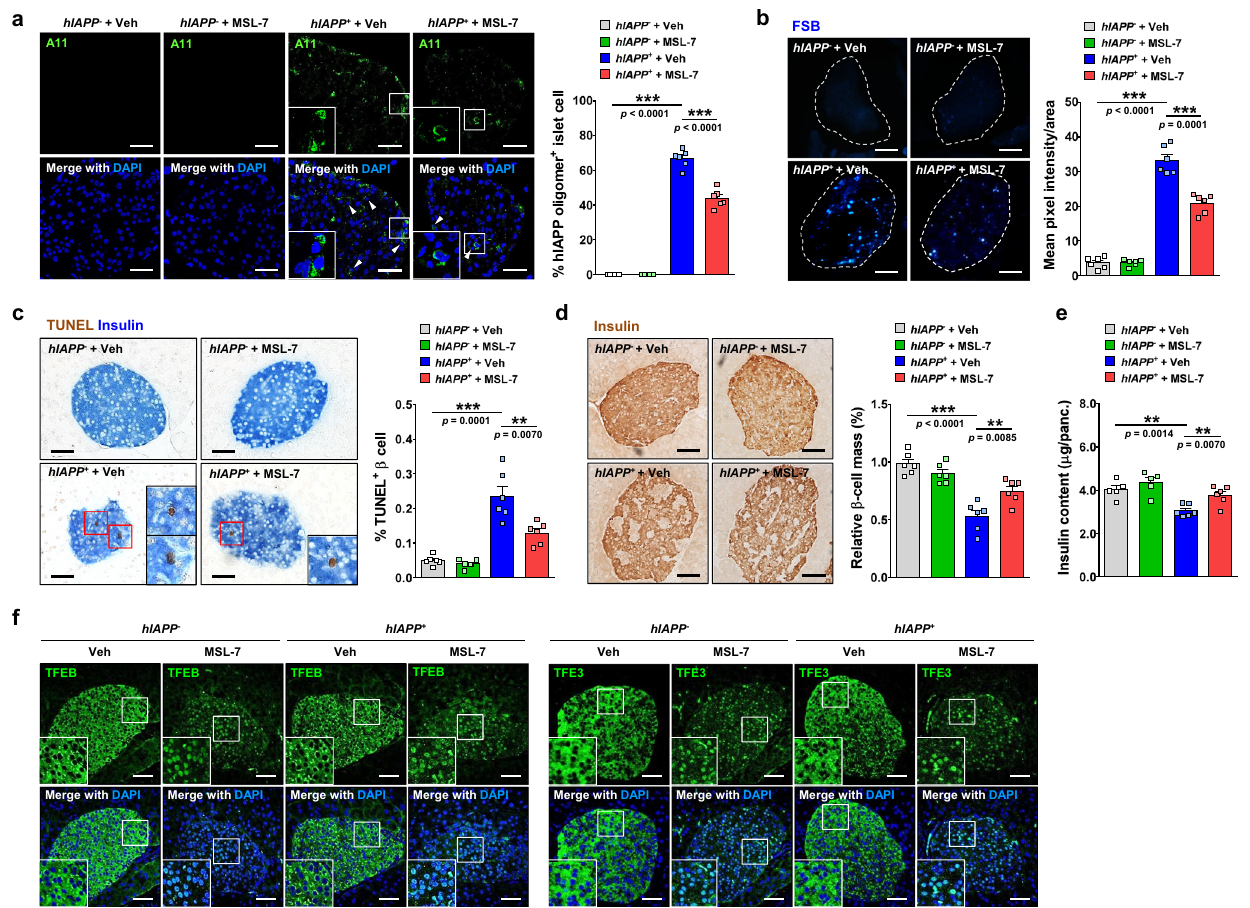
Fig. 6 Pancreatic islets of hIAPP + mice treated with MSL-7. a Percentage of A11 puncta + cells among total DAPI + islet cells in pancreatic sections from HFD-fed hIAPP + mice treated with MSL-7 for 8 weeks was determined by confocal microscopy ( F = 498.6, df treatment = 3, df residual = 20) (right). Representative pictures are shown (left). Inset images were magni fi ed. Arrow heads indicate islet cells with pyknotic nuclei ( n = 6 each, 132 – 148 islets per group). b Mean fl uorescence intensity of FSB staining per islet area was determined using ImageJ ( F = 178.3, df treatment = 3, df residual = 20) (right). Representative pictures are shown (left). ( n = 6 each, 151 – 156 islets per group). c Percentage of TUNEL + β -cells among total β -cells in sections of HFD-fed hIAPP + mice treated with MSL-7 was calculated ( F = 31.5, df treatment = 3, df residual = 20) (right). Representative TUNEL staining is shown (left). Insets (TUNEL + β -cells) were magni fi ed. ( n = 6 each, 180 – 182 islets per group). d Relative β -cell mass in HFD-fed hIAPP + mice treated with MSL-7 was determined by insulin immunohistochemistry and point counting ( F = 22.2, df treatment = 3, df residual = 20) (right). Representative insulin immunochemistry is shown (left). ( n = 6 each, 180 – 182 islets per group). e Insulin content of pancreatic islets from HFD-fed hIAPP + and hIAPP − mice treated with MSL-7 was measured by ELISA, which was normalized to the total pancreas weight ( F = 9.5, df treatment = 3, df residual = 18). ( n = 5 for Veh-treated hIAPP − mice, n = 5 for MSL-7-treated hIAPP − mice, n = 6 for Veh-treated hIAPP + mice and n = 6 for MSL-7-treated hIAPP + mice). f Immun fl uorescence of pancreatic sections from HFD-fed hIAPP + and hIAPP − mice treated with MSL-7 using anti-TFEB (left) and anti-TFE3 antibodies (right). Insets were magni fi ed to show colocalization of TFEB/TFE3 with nuclear DAPI. ( n = 6 each) All data in this fi gure are the means ± SEM from